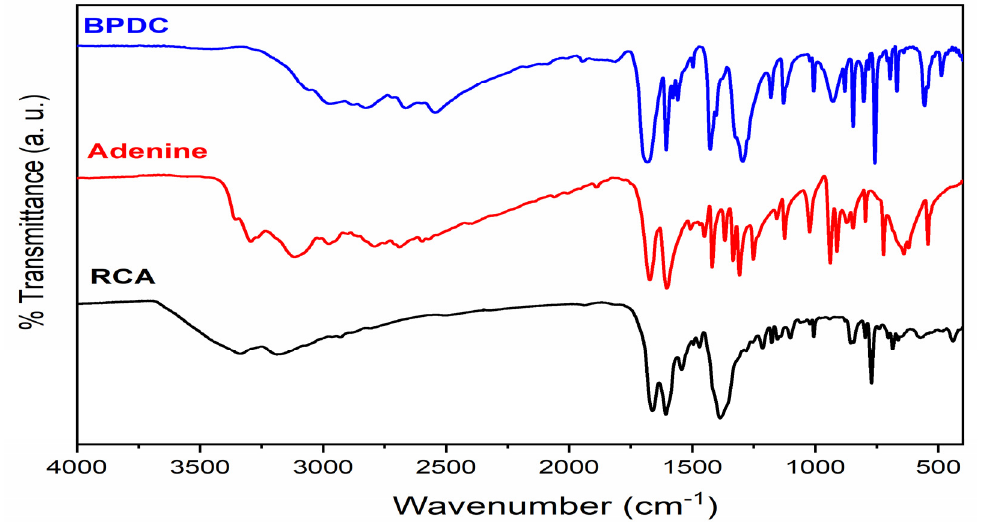
Figure 1. Infrared vibrational spectrum of the RCA compound. Table 1. Main frequencies in the infrared region of the material obtained (RCA) and that of the literature (bioMOF-100) [21].